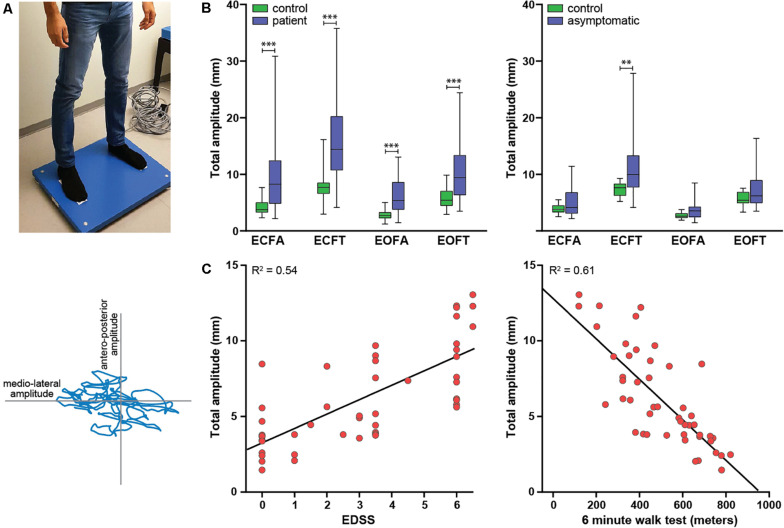
Study overview. (A) Experimental setup. Upper panel: subject standing on the force plate in the feet-apart condition. Lower panel: body sway output. The body sway amplitude is the displacement of the center of gravity in the anteroposterior (y-axis) or mediolateral (x-axis) direction, the sway path is the distance traveled by the blue line. (B) Differences in body sway amplitude between patients and controls (left) and asymptomatic patients and an age-matched selection of controls (right). (C) Two examples of the association between clinical severity of myelopathy and body sway: EDSS and total sway amplitude (left) and 6MWT and total sway amplitude (right). The lines represent simple linear regression lines.